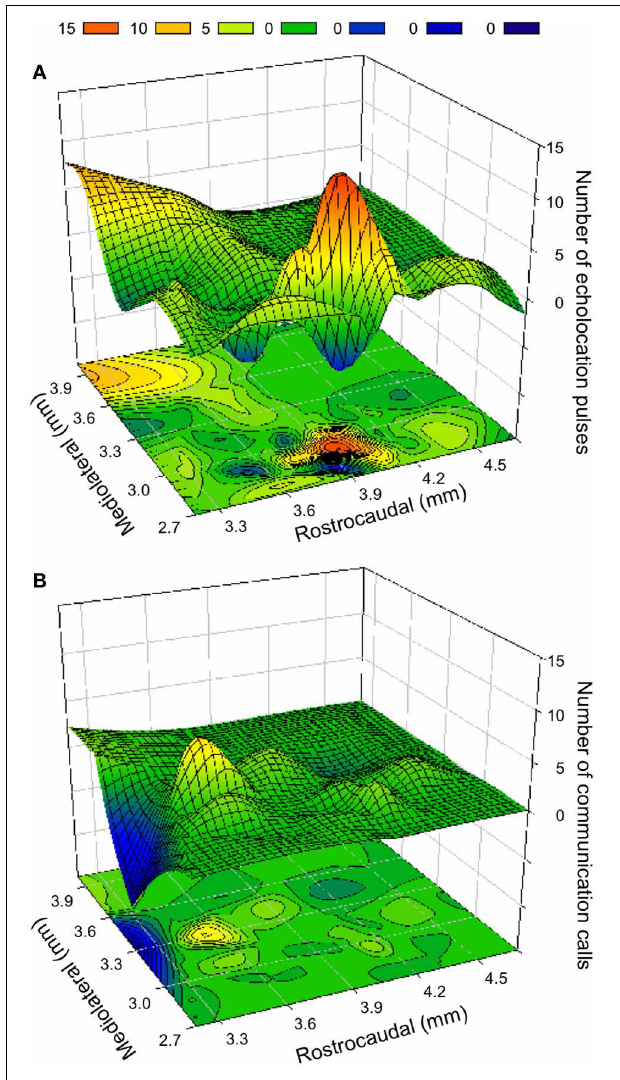
FIGURE 6 | Contour plots (below) and surface topographies (above) for frequency of vocalization elicited by electrical and kainic acid stimulation in the BA and CA region of the amygdala. (A) Distribution of sites that elicited echolocation pulses. The bump in the foreground overlaps with the coordinates of the CA region, whereas the large peak is well within the boundaries of the BA. (B) Distribution of the sites that elicited social calls. The color scale for the frequency of call occurrence is indicated at the top. Negative points resulting from best fit function are equated to 0. The rostrocaudal boundaries of each plot are given relative to the position of the intersection between olfactory bulbs and frontal cortex. For obtaining stereotaxic coordinates, the eyes and nostrils are aligned in the horizontal plane. The depth is relative to the surface of the brain. The mediolateral distance is measured from the